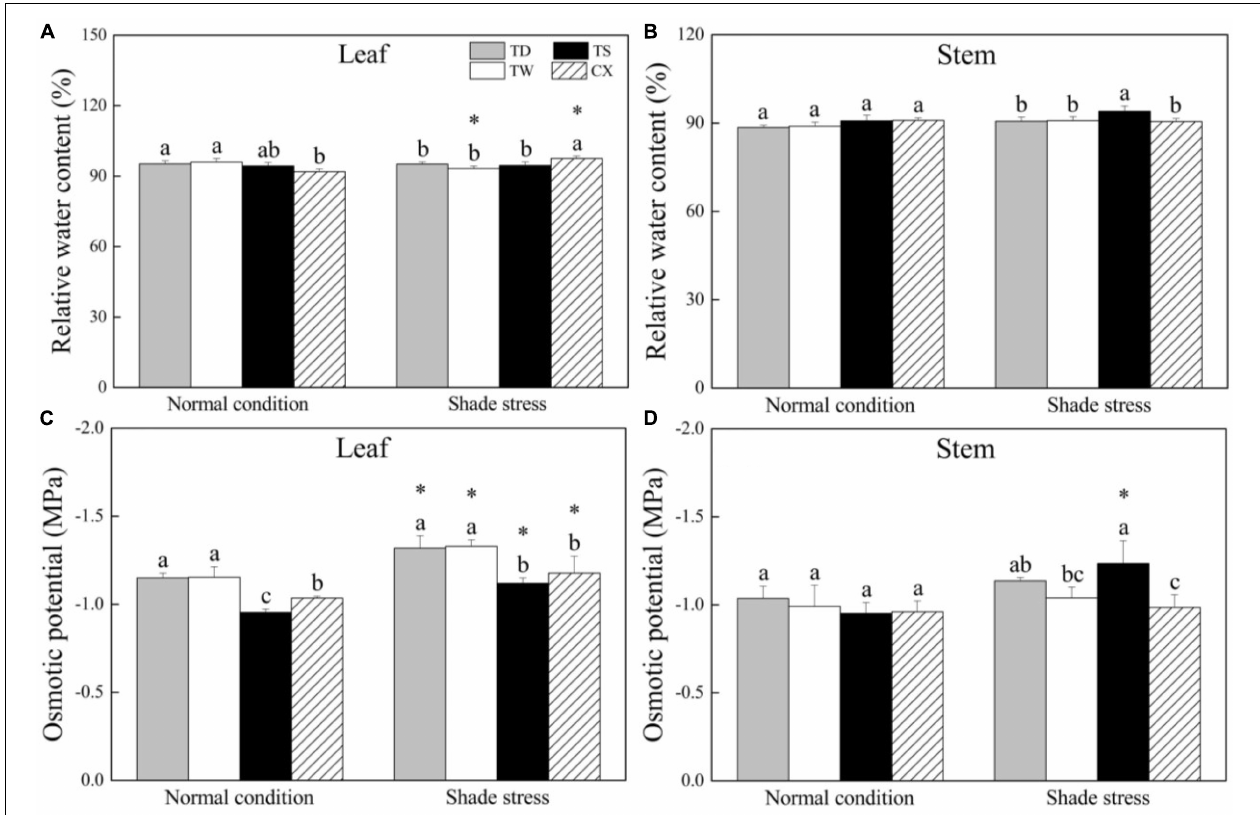
FIGURE 2 | Effects of shade stress on (A) relative water content in leaf, (B) relative water content in stem, (C) osmotic potential in leaf, and (D) osmotic potential in the stem of four bermudagrass cultivars. Vertical bars indicate the ± SE of mean ( n = 4). Different letters above columns indicate significant differences ( p ≤ 0.05) among the four cultivars under normal conditions or shade stress. The asterisk ( ∗ ) above letter indicates a significant difference ( p ≤ 0.05) in one particular cultivar between normal conditions and shade